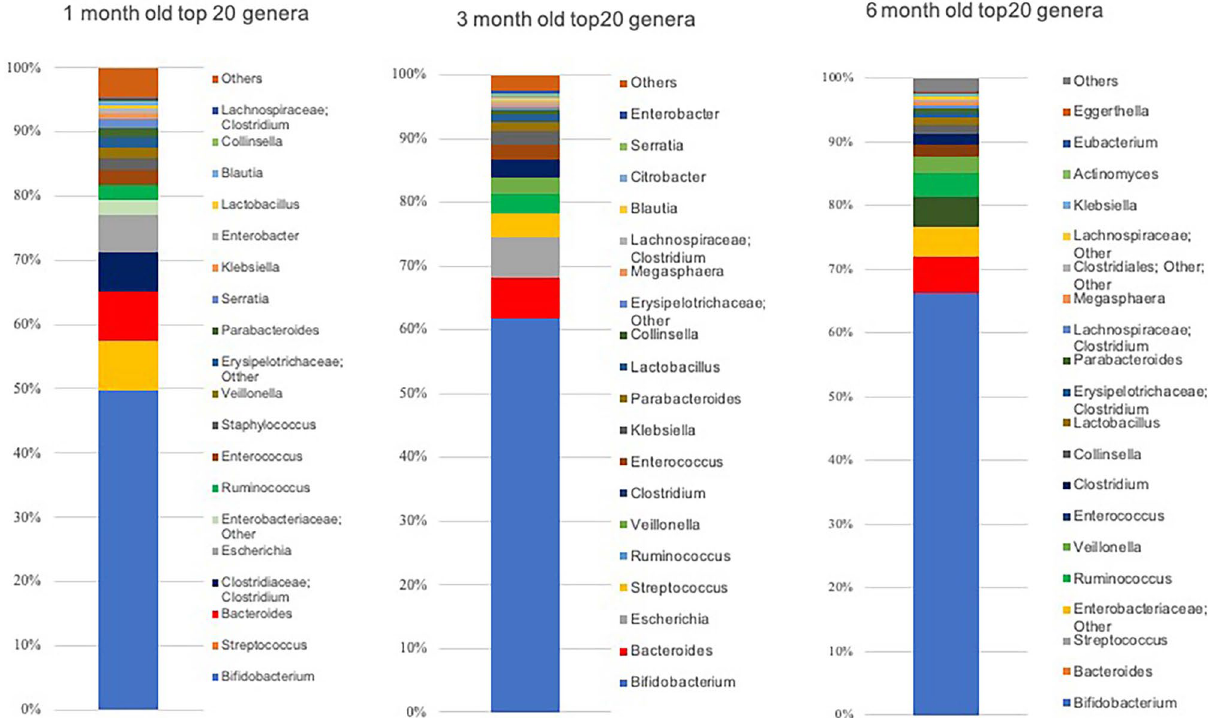
Figure 1. Mean occupancies of the top 20 bacterial genera constituting the intestinal microbiome at 1, 3, and 6 months after birth. At each age, the occupancies of the top 20 genera (others are indicated as ‘Others’) are shown as 100% stacked columns. The genera are shown in the order of higher occupancy from the bottom to the top. This figure was generated using Microsoft Excel for Mac 2016 (https ://www.micro